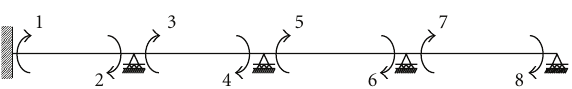
Figure 5: Reference coordinates for the first